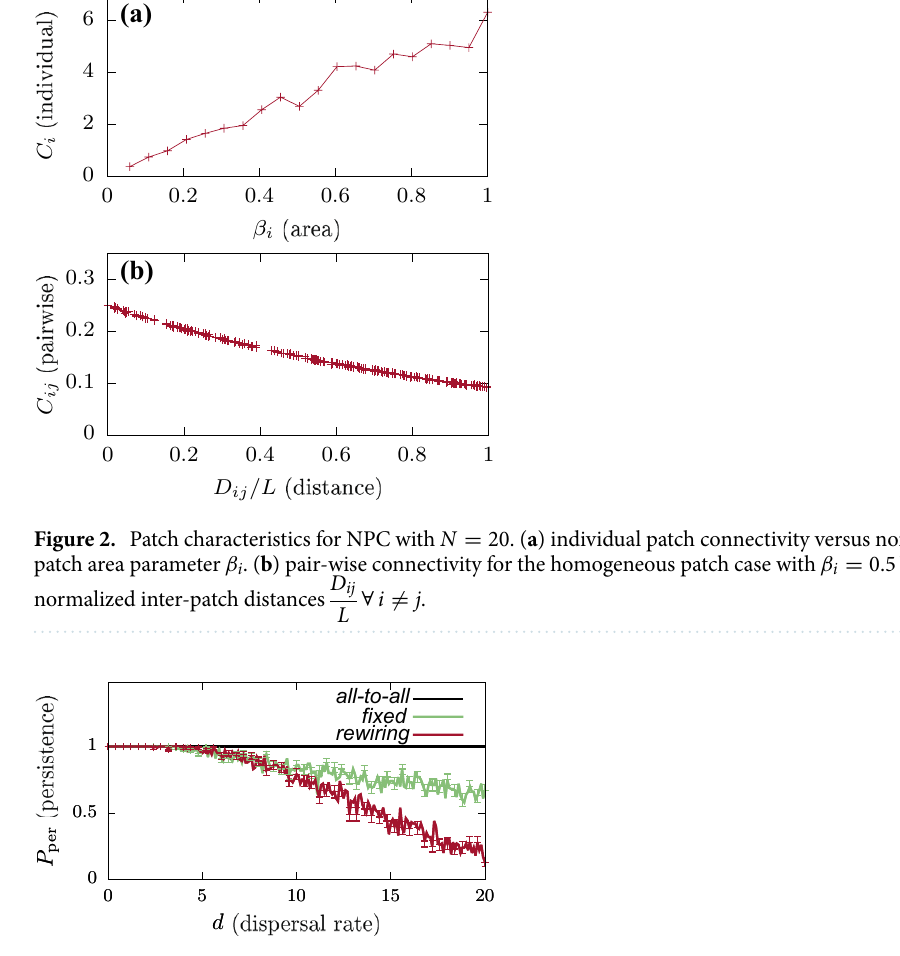
Figure 3. Persistence probabilities P per as a function of dispersal rate d , for different connectivity configurations 20 and dispersal efficiency δ 1 . Curves: all-to-all connected (black), fixed NBM (green), and with N = = rewiring NBM (red) (rewiring every 100 time units). The ensemble sizes (number of network realizations) 100 for all three cases. Standard error values SE ( P per ) , for NBM for these calculations are fixed at N ensemble = calculations are highlighted by error bars every four data points to avoid graph overcrowding. Corresponding biomass calculations can be seen in the Online Appendix Fig.